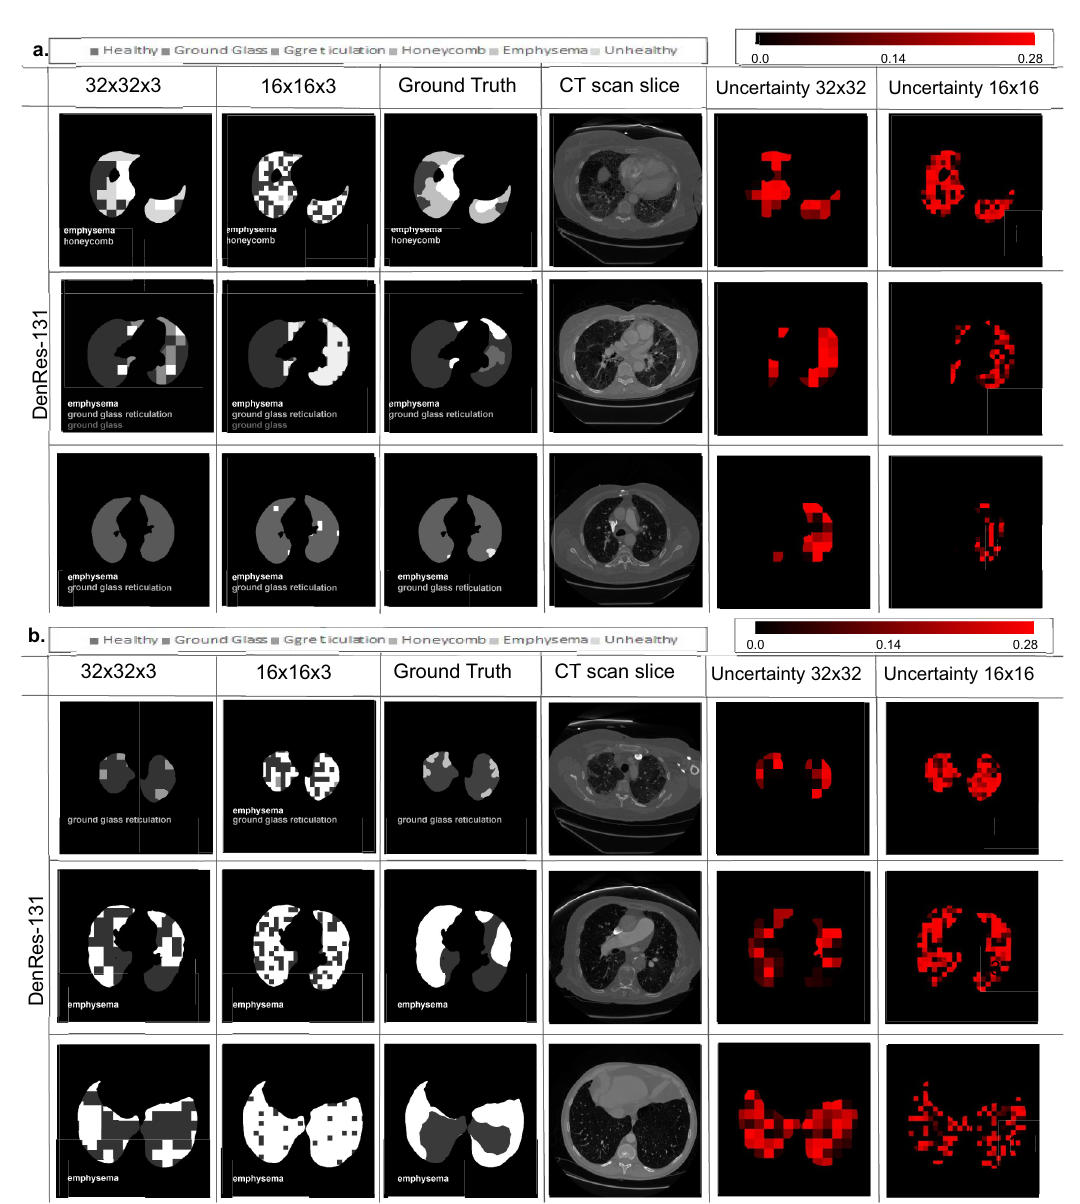
Figure 4. The multi-classification results of six different patients of the ‘unseen’ cohort (PART 2). ( a , b ) From left to right the prediction results of the patch sizes ( 32 × 32 × 3 , and 16 × 16 × 3 ), the radiologist ground truth, the patient CT slice of short axis, the uncertainty mapping of 32 × 32 × 3 , and the uncertainty mapping of 16 × 16 × 3 . The six different classes are showing in gray-scale colours. The uncertainty scale is with red-scale from 0.00 to 0.30